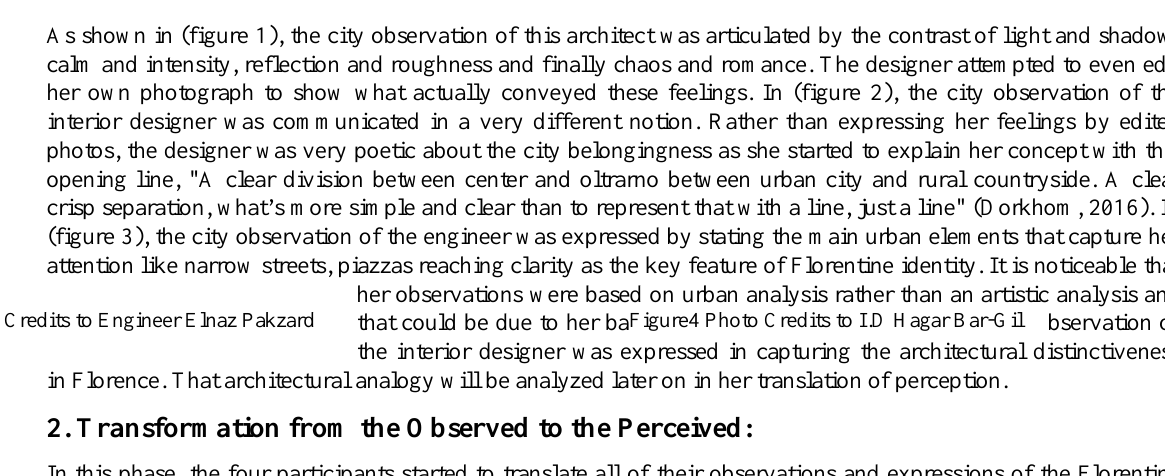
Figure3 Photo Credits to Engineer Elnaz Pakzard Figure4 Photo Credits to I.D Hagar